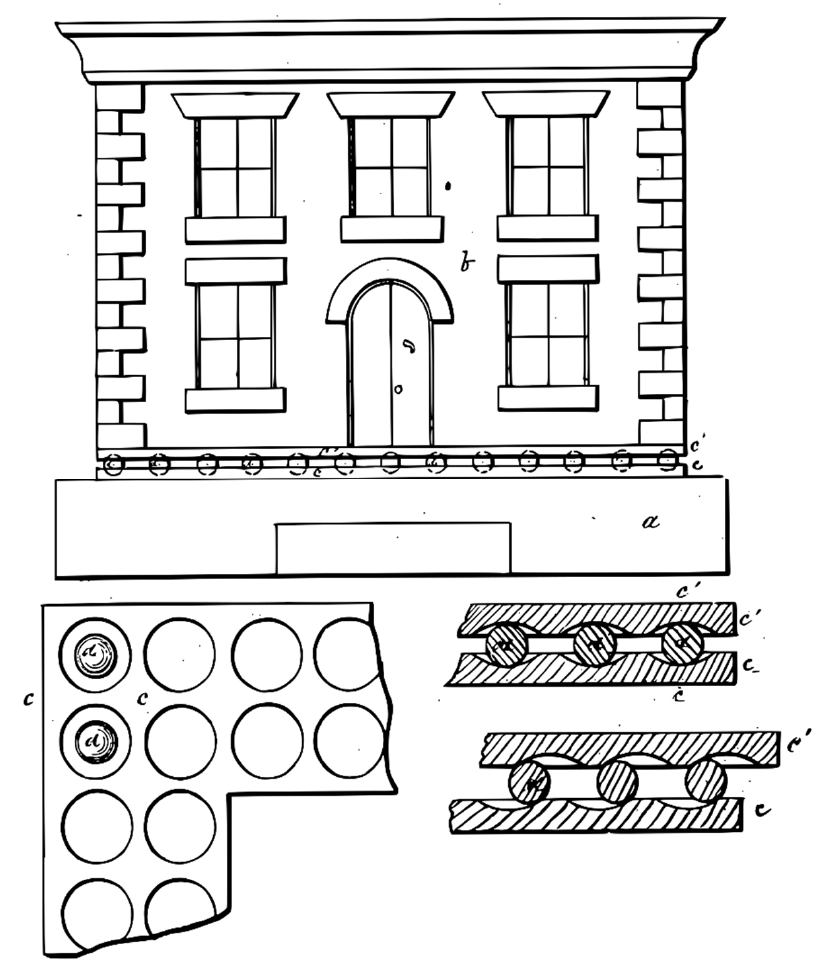
Figure 1. Isolation system patented by Touaillon [4].